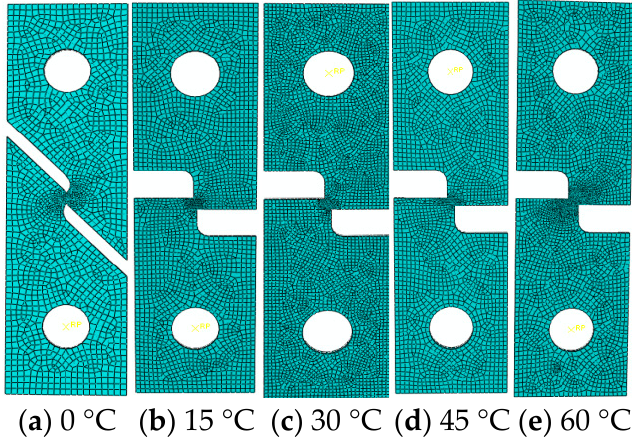
Figure 11. ( a – e ) Finite element grid diagram of shear specimen.